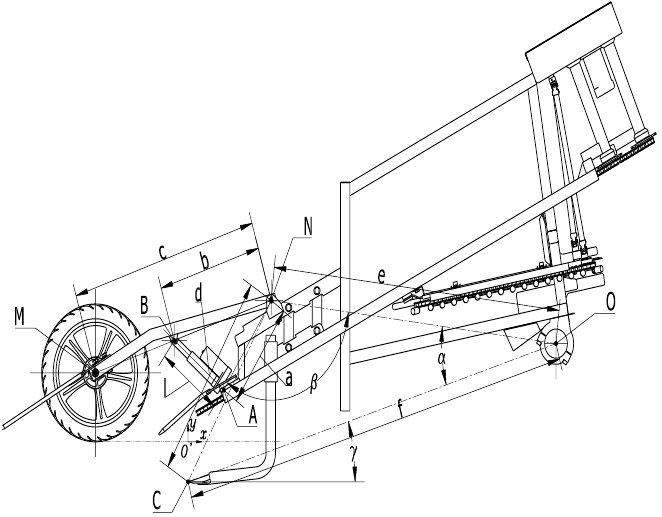
Figure 9. Digging depth control mechanism.